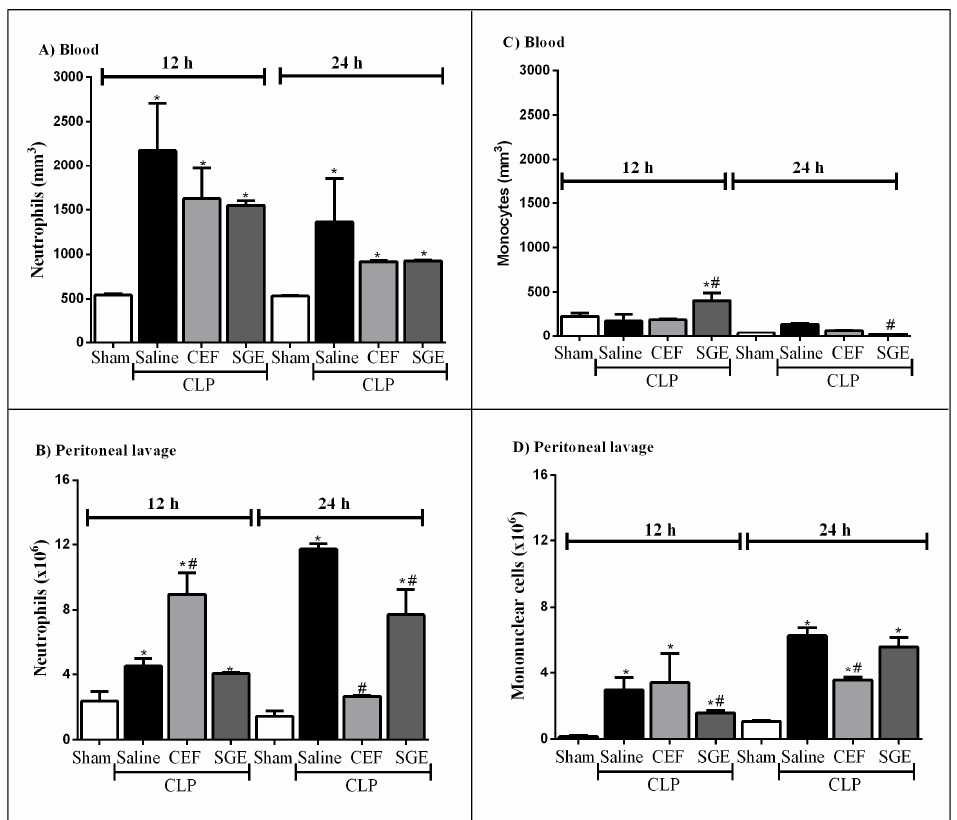
Figure 3. Effect of SGE on the number of circulating cells and migration to the peritoneal cavity in animals with sepsis. ( A ) Neutrophils in the blood. ( B ) neutrophils in the peritoneal cavity. ( C ) monocytes in the blood. ( D ) Monocytes in the peritoneal cavity. Total cell counts in the peritoneal cavity and blood were determined 12 h and 24 h after CLP. The results were expressed as the mean ± SD (five animals/group). * p < 0.05 compared to the sham control group; # p < 0.05 compared to the saline control group. CLP: cecal ligation and puncture; SGE: salivary gland extract; CEF: ceftriaxone.